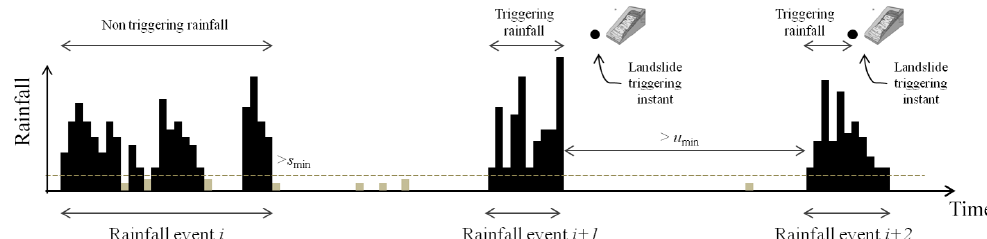
Figure 4. Sketch illustrating the algorithm for the identification of triggering and non-triggering rainfall events, and relative parameters s min and u min . When a landslide is triggered in a dry period, it is attributed to the whole event preceding it; otherwise, only the part of the event preceding the landslide-triggering instant is considered. For non-triggering rainfall (the first one in the diagram), duration and intensity are computed considering the entire rainfall